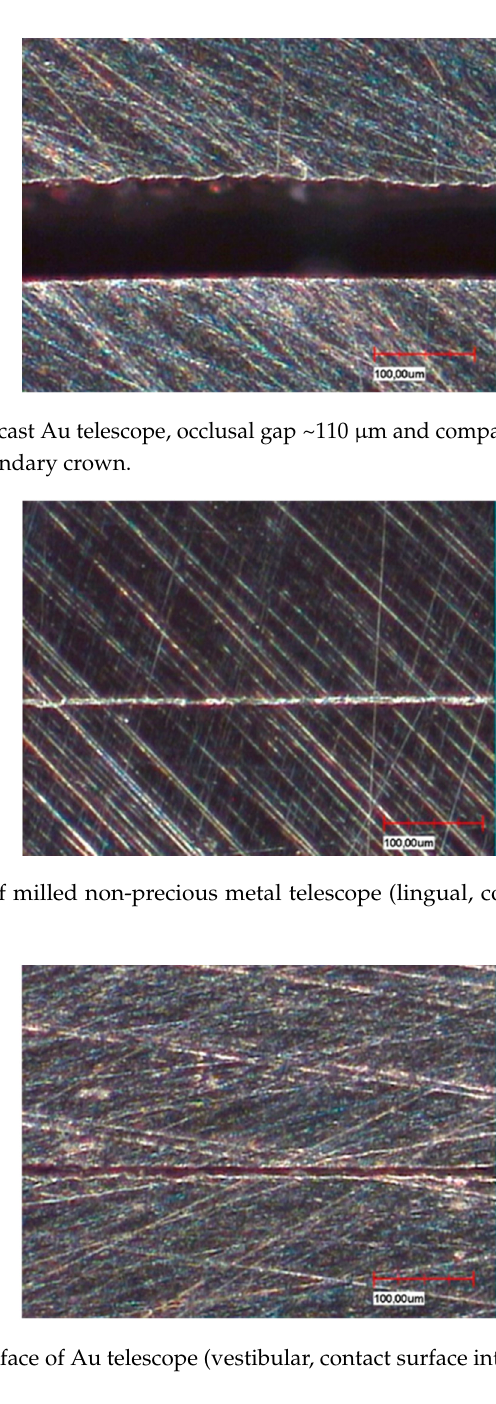
Figure 5. Cut surface of milled non-precious metal telescope, occlusal gap ~220 µm.